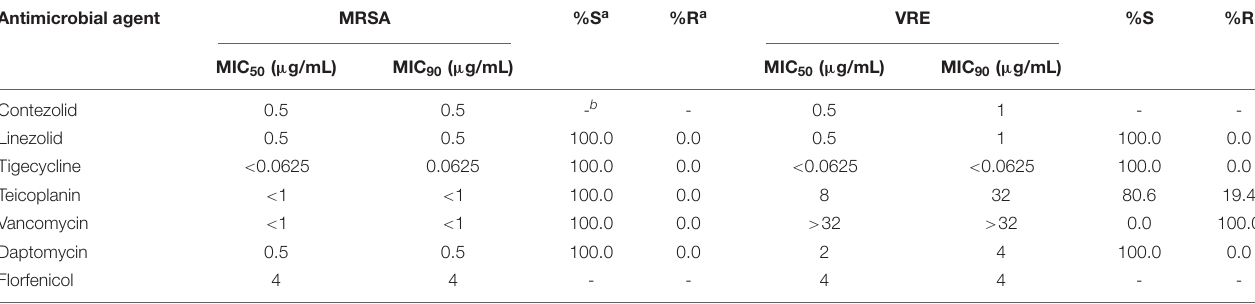
TABLE 2 | In vitro activity of contezolid and comparator agents against MRSA and VRE strains. Antimicrobial agent MRSA